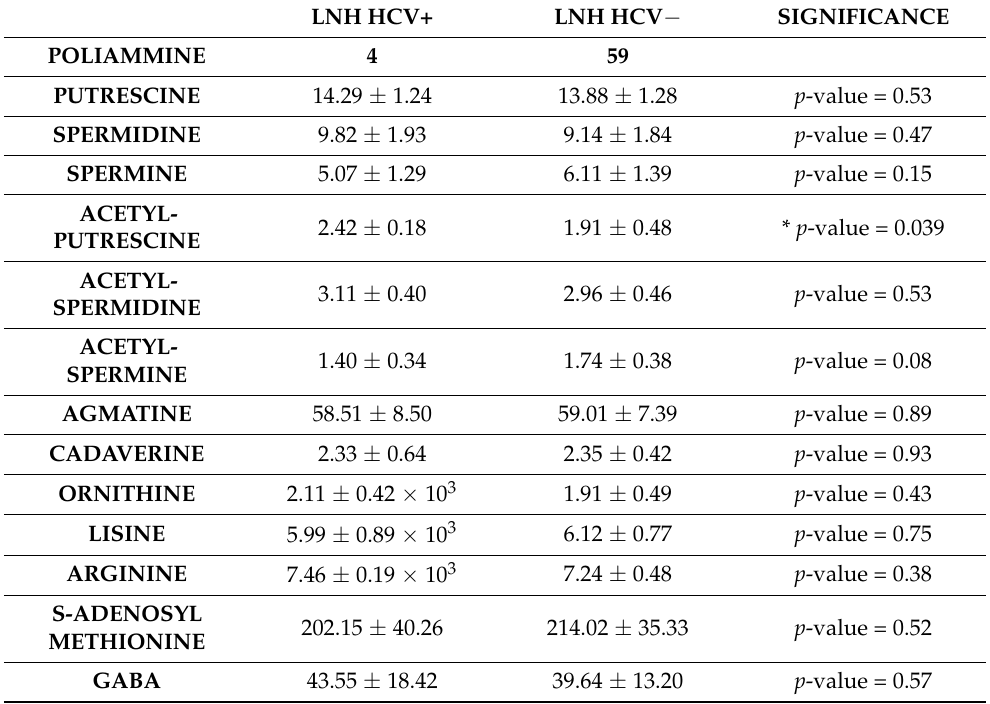
Table 5. Levels of polyamines, related amino acids and metabolites in LNH patients (HCV+ and HCV − ). Student’s t -test was applied unpaired between HCV+ and HCV − , * p < 0.05 as statisti- cally